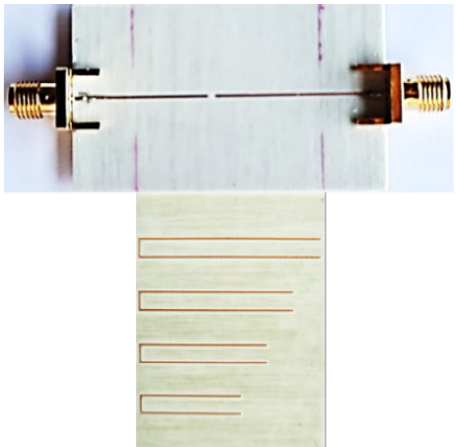
Figure 9. Photograph of the fabricated reader and encoder. Reprinted with permission from [65].